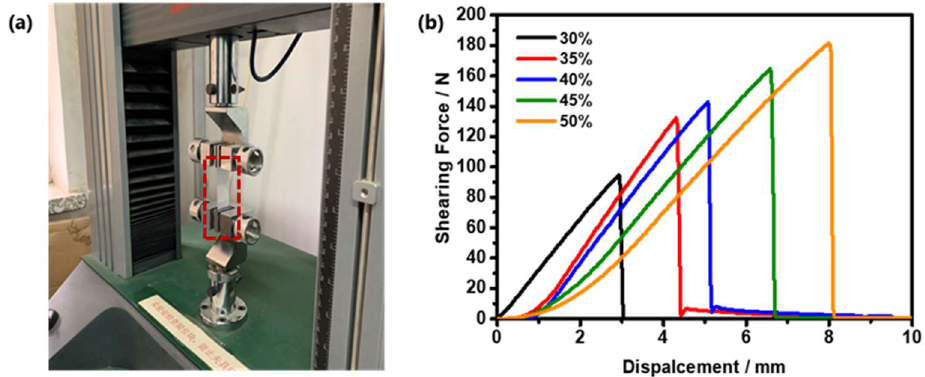
Figure 2. ( a ) Photograph of the shearing-strength test; ( b ) shearing-force displacement curves of Samples A1–A5. Samples A1–A5.